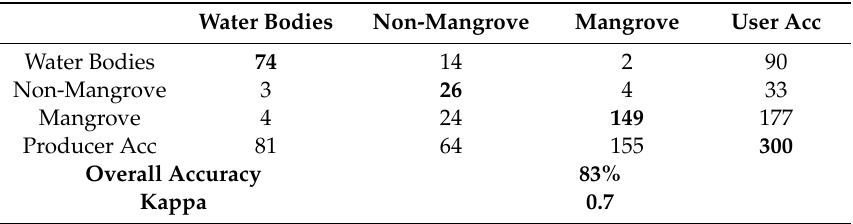
Table 5. Confusion matrix of classification accuracy in 2015.